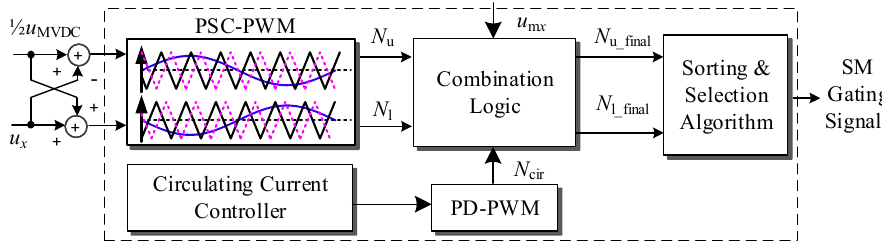
Figure 6. Modulation scheme (the blue sinusoidal solid line represents the modulation signal, while the purple triangular dotted line represents the carrier).